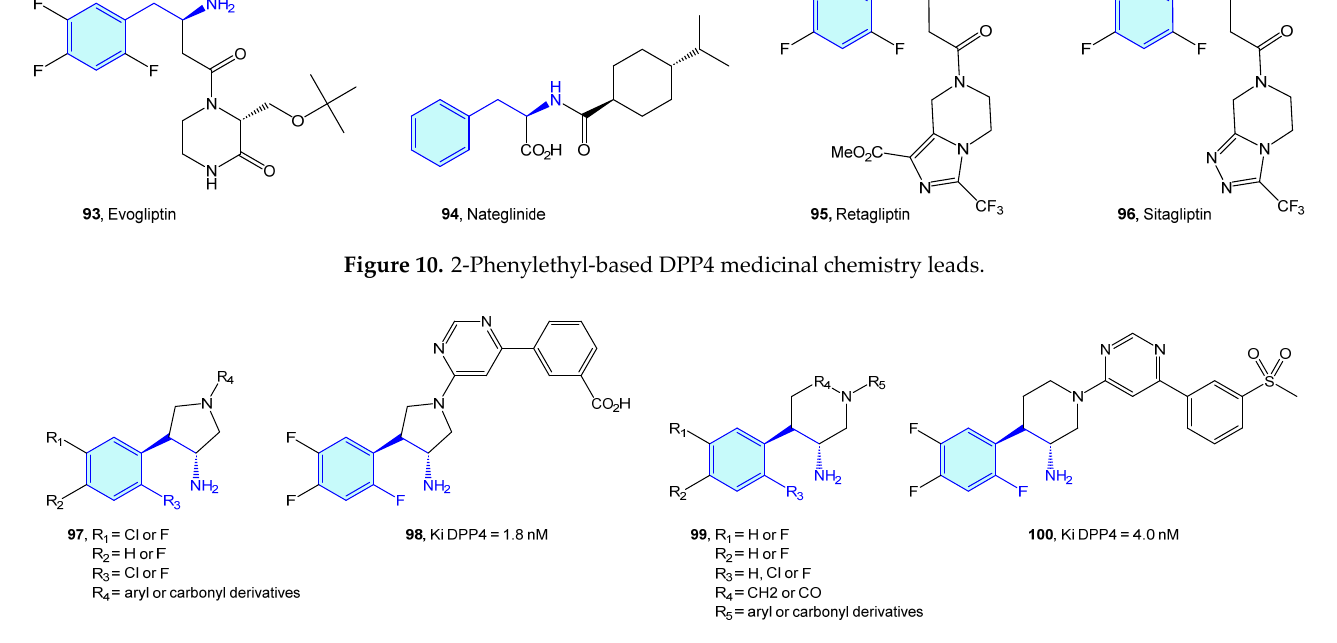
Figure 10 . 2-Phenylethyl-based DPP4 medicinal chemistry leads. Table 3. DPP4 medicinal chemistry leads.